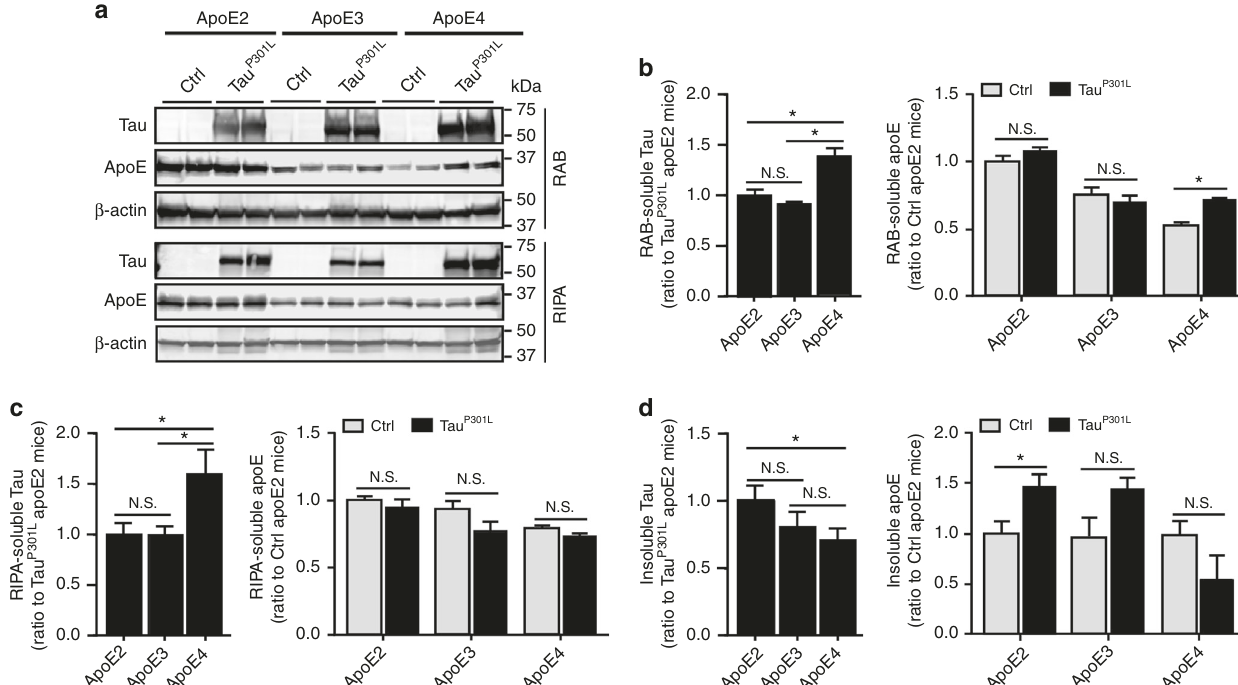
Fig. 3 Increased insolubility of tau and apoE in Tau P301L -apoE2 mice. The cortical brain tissues from control mice (Ctrl, AAV-GFP-injected) and Tau P301L - apoE2, -apoE3, and -apoE4 mice at 6 months of age were sequentially extracted by RAB, RIPA, and FA buffer. Soluble tau (HT7 detection) and apoE in RAB ( a , b ) and RIPA fractions ( a , c ) were examined by western blotting ( n = 6 mice per group, mixed gender). Results were normalized to β -actin levels. Insoluble tau and apoE in FA fraction was detected by ELISA ( d n = 6 mice per group, mixed gender). Data are expressed as mean ± SEM relative to apoE2- TR mice. Mann-Whitney tests followed by Bonferroni correction for multiple comparisons were used. * P < 0.0167; N.S. not signi fi cant